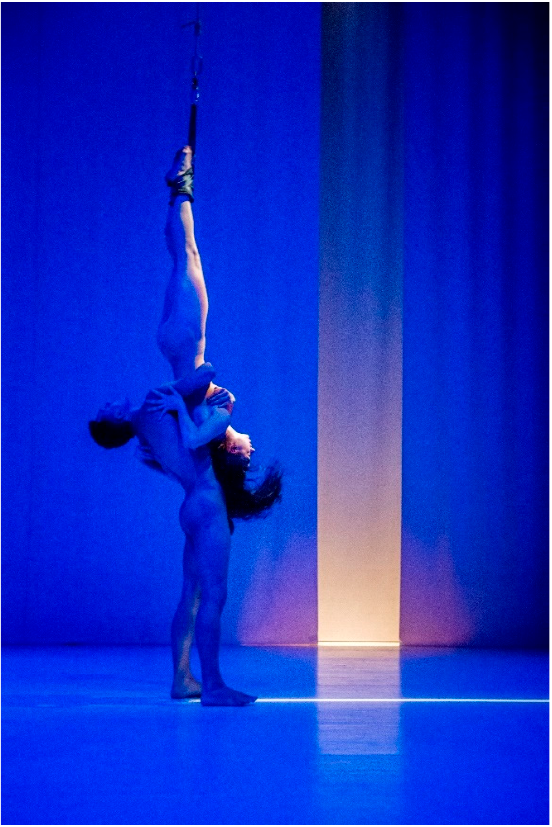
Figure 2. Tricks & Tracks —© Katalin Bobál, bobal photography.